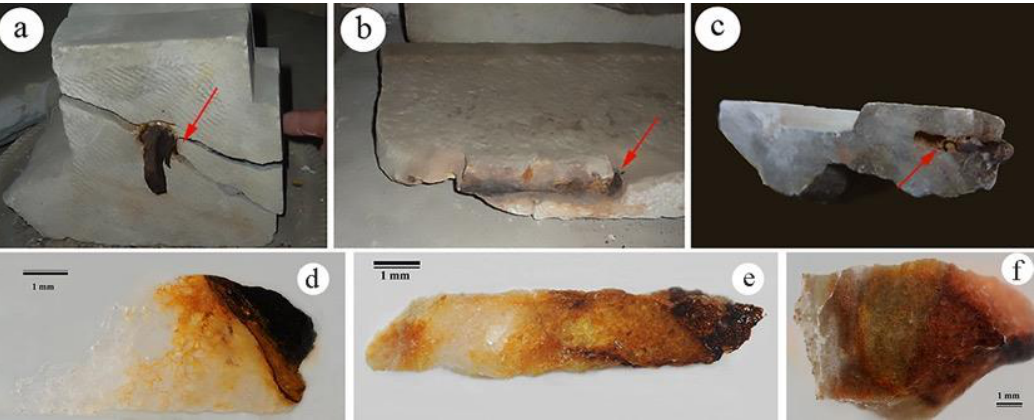
Figure 1. Sampling points, evidenced by red arrows, and images of cross sections acquired in reflected light (25×), respectively, for samples NS1 ( a , d ), NS3 ( b , e ) and NS8 ( c , f ). OM (with analysis in polarized light) showed important differences in the petrography of the three historical marble samples (Figure 2).